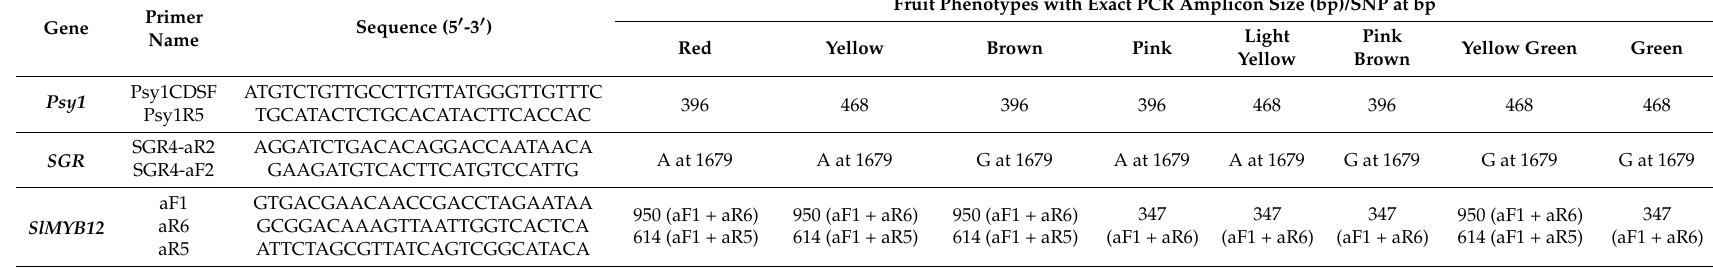
Table 2. List of markers designed to follow the mutations in Psy1 , SGR , and SlMYB12 responsible for the eight fruit color phenotypes in the segregating F 2 population with their respective PCR amplicon sizes and SNP positions in the